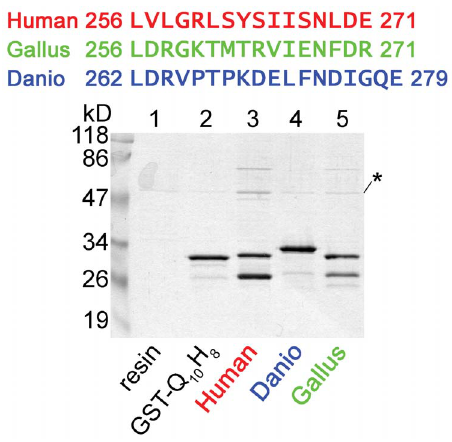
Figure 6. The fragments of zebrafish and chicken TRESK, homologous to the tubulin-binding motif of the human channel, do not efficiently interact with tubulin. Fragments of TRESK from Danio rerio (zebrafish, 18 amino acids) and Gallus gallus (chicken, 16 amino acids), homologous to region 256–271 of the human channel (as shown on the top of the figure), was tested in pull-down assays. Neither the fragment from Danio ( lane 4 ) nor that from Gallus ( lane 5 ) interacted with tubulin so strongly as the tubulin-binding motif of human TRESK ( lane 3 ). In this experiment, the short peptide fragments were inserted between N-terminal GST and C-terminal Gln 10 His 8 tags, thus they were not located at the extreme C-terminus of the fusion proteins. Ni-NTA resin ( lane 1 ) and GST-Gln 10 His 8 with no insert (GST-Q 10 H 8 , lane 2 ) were used as controls.